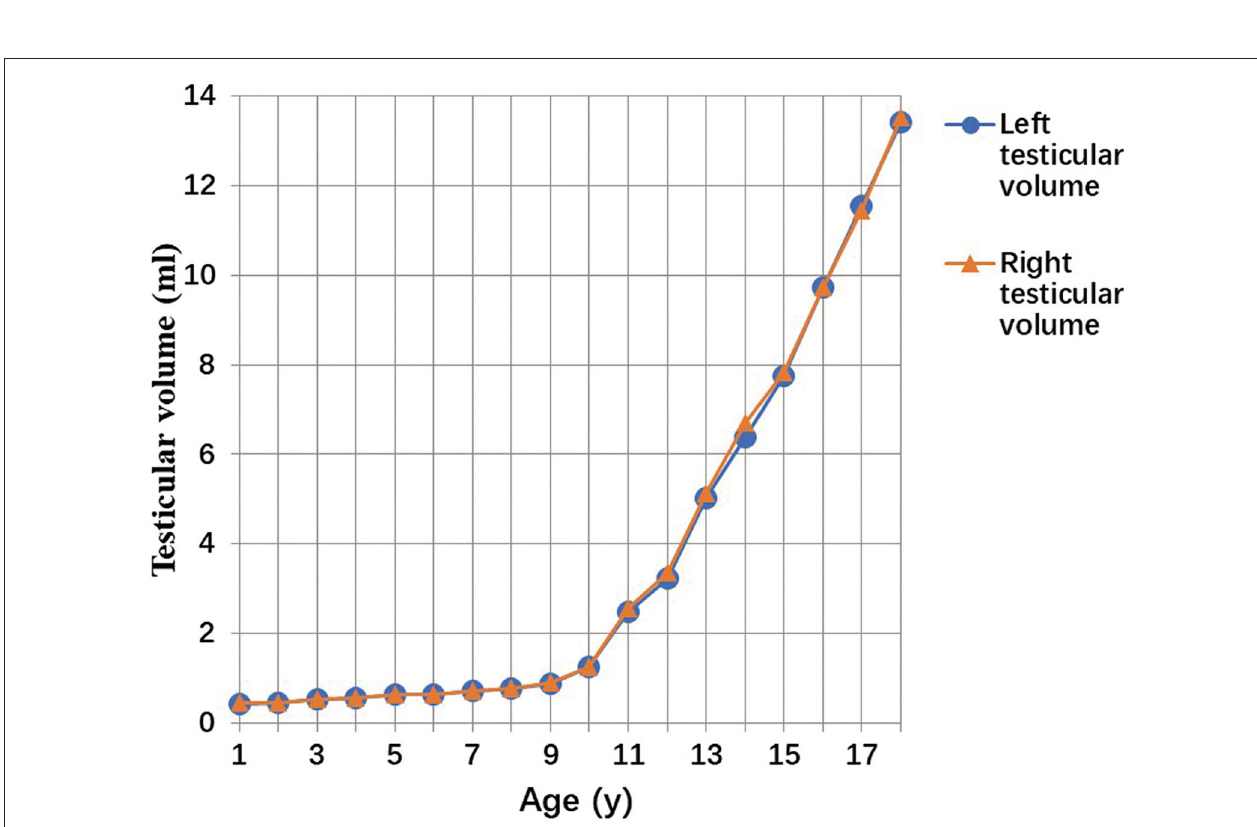
FIGURE 2 | The line chart of left and right testicular volume.